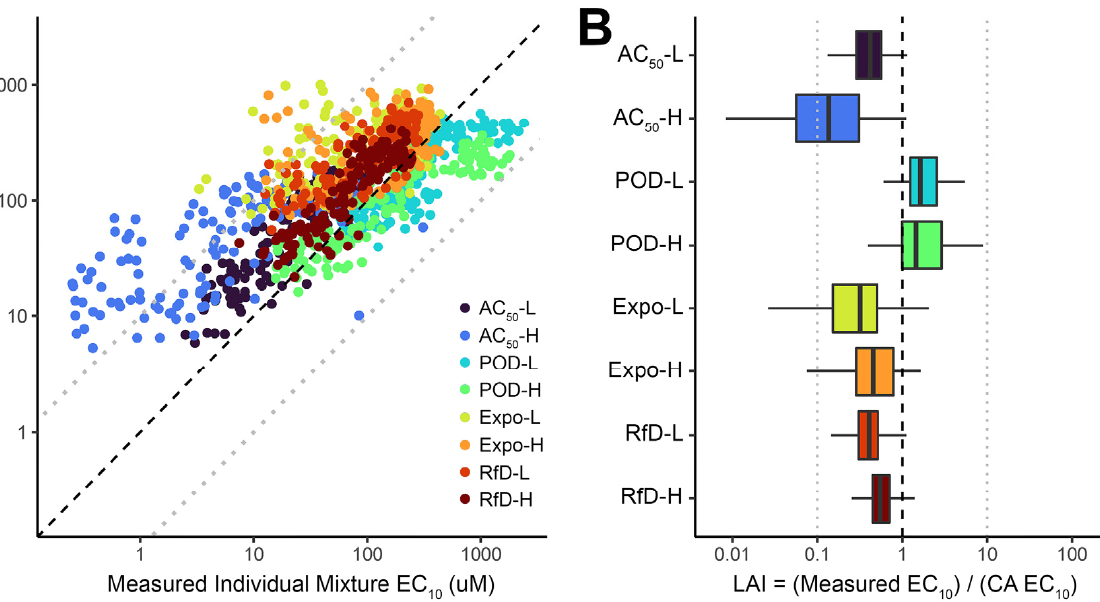
Figure 2. Comparison of mixture points of departure (POD = EC 10 ) measured and predicted by con- centration addition (CA) for each individual cell line. ( A ) . Scatter plot of the median Bayesian pos- terior estimate of measured and CA-predicted EC 10 . ( B ). Distribution across individuals of Loewe Additivity Index (LAI) for each mixture. ( C ). Heatmap and hierarchical clustering of log 10 (LAI) across mixtures and individual cell lines. In panels ( A , B ), dashed line indicates equality, and light dotted lines indicates 10-fold differences in either direction. In panels ( B , C ), LAI < 1 (or log 10 (LAI) < 0) indicates greater-than-additive effects (“synergy”) and LAI > 1 (or log 10 (LAI) > 0) indicates less- than-additive effects (“antagonism”). 3.2. Comparison of Concentration Addition Approaches for the Median and the Sensitive (First Percentile) Individuals Figure 3 summarizes the accuracy and precision of predicted CA PODs for the me- dian individual compared with those obtained from the mixture experiments. In general, most EC 10 and LAI values are located within 10-fold lines in Figures 3A and 3B, respec- tively. Among three different methods for CA prediction, EC 10 of the CA lognormal sum approximation (CA LNSum ) shows the best correlation with the measured value, with the greatest accuracy and precision. However, predictions for the other two CA methods, CA Indiv and CA Default , were quite similar, although CA Indiv showed greater uncertainty for Expo-L, Expo-H, and RfD-L mixtures. As with the results above for individuals evaluated separately, the AC 50 -H mixture also has the lowest EC 10 and LAI values, showing a greater- than-additive effect of almost 10-fold, and two POD mixtures have AIs greater than 1, demonstrating a slightly less-than-additive effect. The AI values across all CA approaches and mixtures range from 0.035 to 3.71.